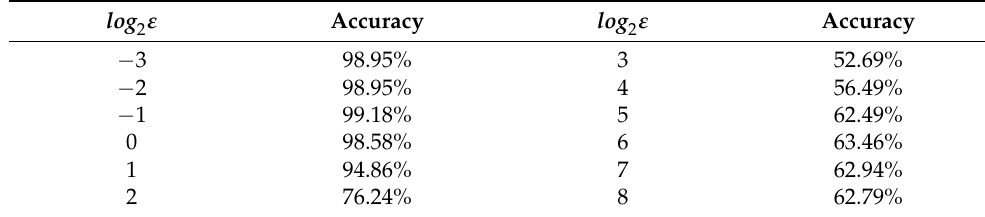
Table 3. Accuracy of the deep model by different attack parameter ε